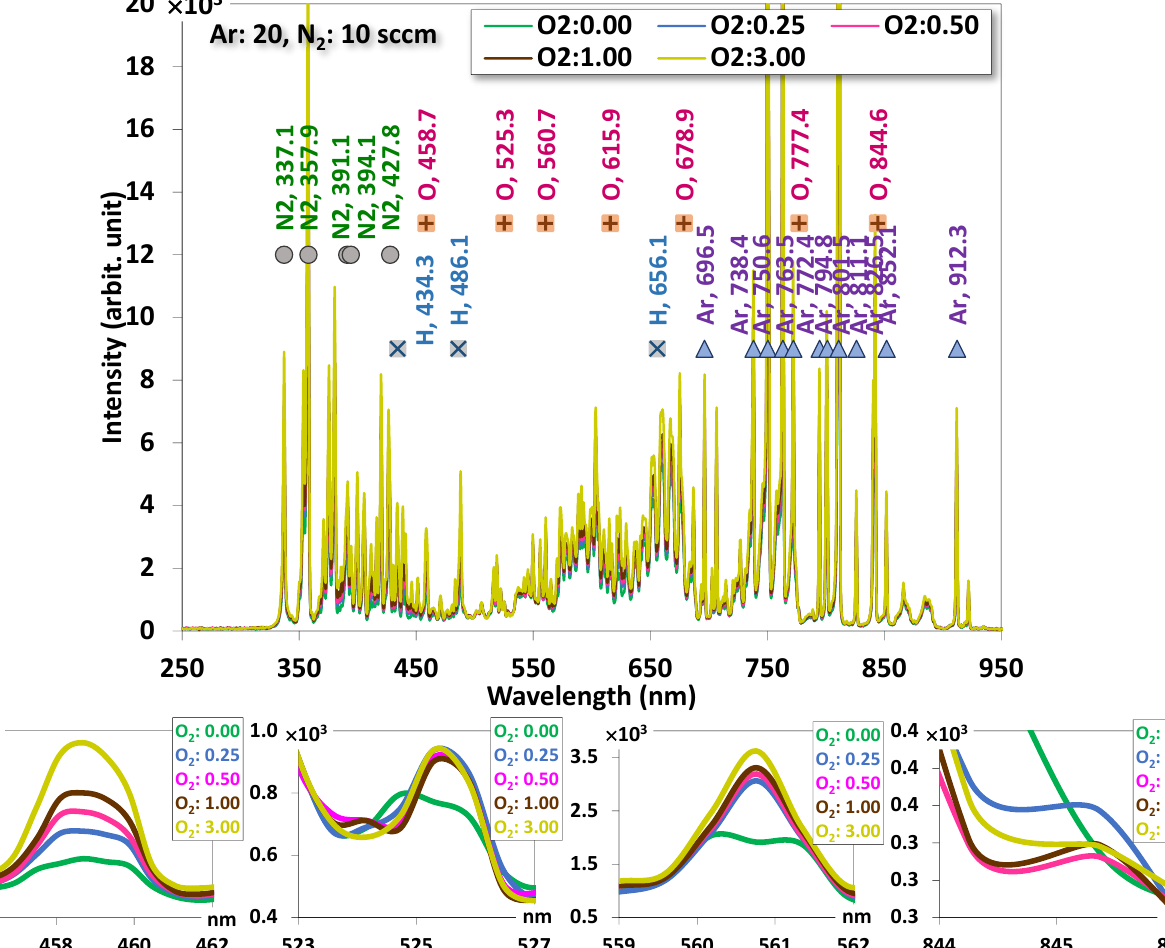
Figure 2. Variations of OES observed from the chamber plasma under different oxygen flow rates and N 2 = 10 sccm. The selected small figures are oxygen peaks located at wavelengths 458.7, 525.3, 560.7, and 844.6